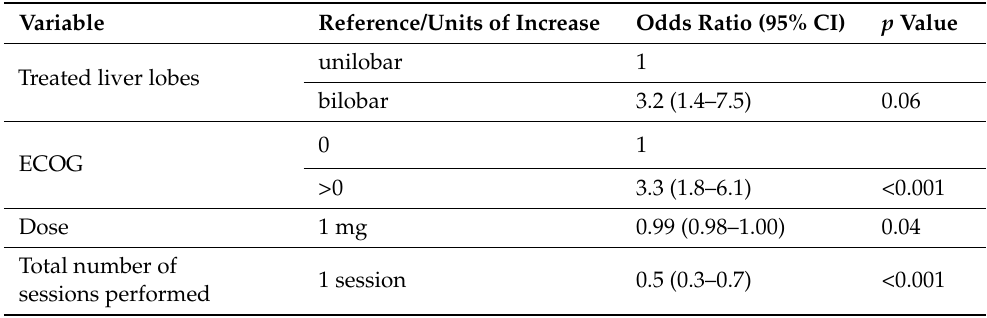
Table 4. Multivariable binary logistic regression analysing the relationship between baseline- and treatment associate factors and sessions with ≥ 1 acute AEs. Following variables were considered in the multivariable model: ECOG, treated liver lobes, number of lines of liver-directed systemic therapy, dose and total number of sessions